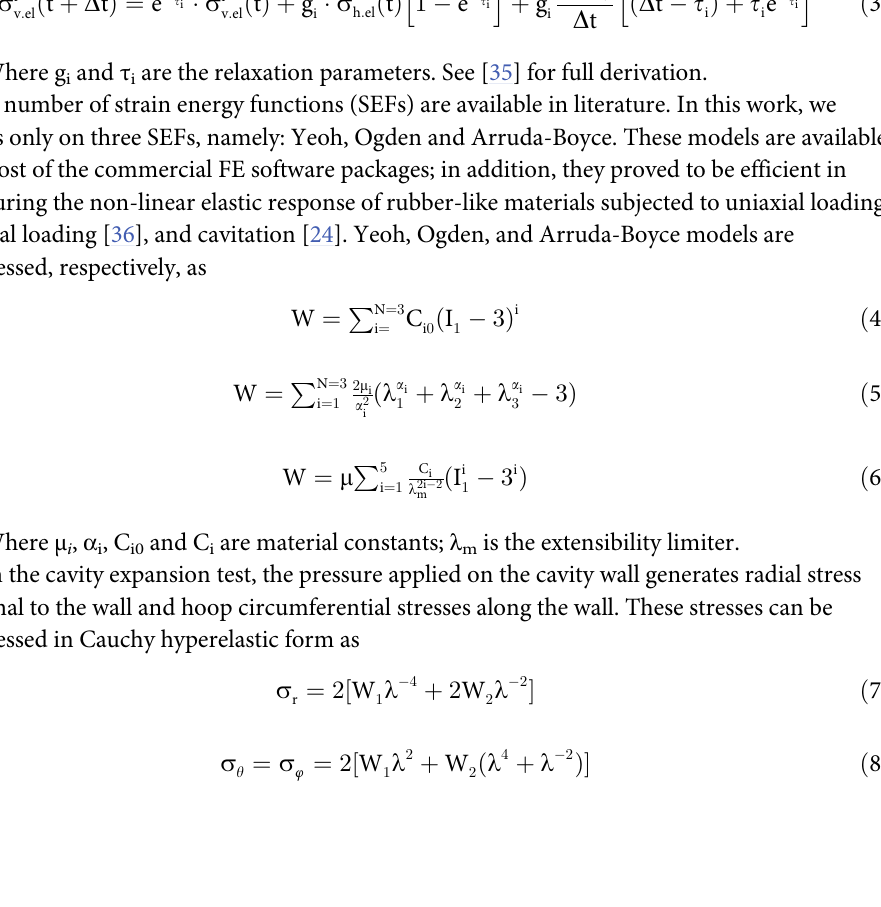
PLOS ONE | https://doi.org/10.1371/journal.pone.0233021 May 12,